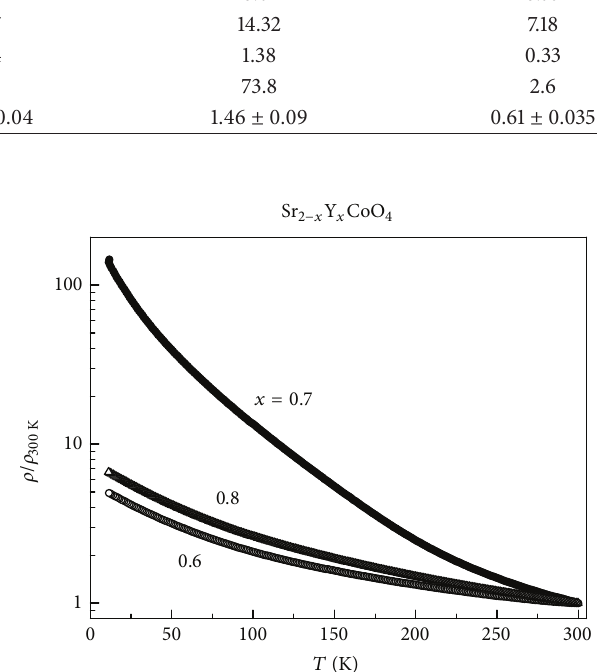
Figure 4: Zero-field cooled (ZFC) susceptibility 𝜒(𝑇) of Sr 1.4 M 0.6 CoO 4 , (M = Y and Pr) at 𝐻 = 0.20 kOe. The corresponding magnetic transitions indicated by arrows.